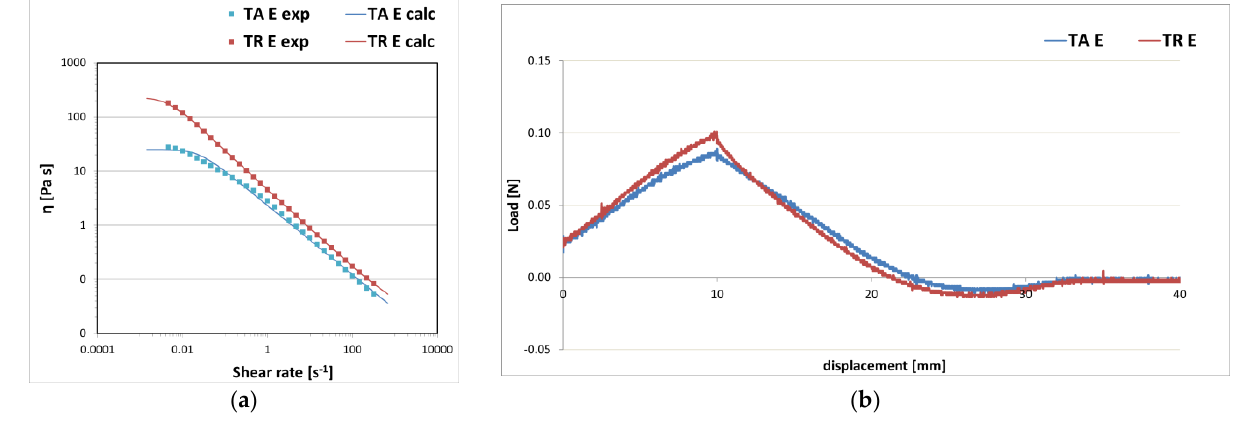
Figure 10. Rheological and texture curves obtained for the gel – creams samples TA E prepared with T at 0.2% w / w , A at 0.2% w / w and E at 0.3% w / w and TR E prepared with T at 0.2% w / w , R at 0.2% w / w and E at 0.3% w / w : ( a ) viscosity curves (exp) as a function of the shear rate fitted with the Carreau−Yasuda model (calc); ( b ) texture curves obtained with an immersion test.